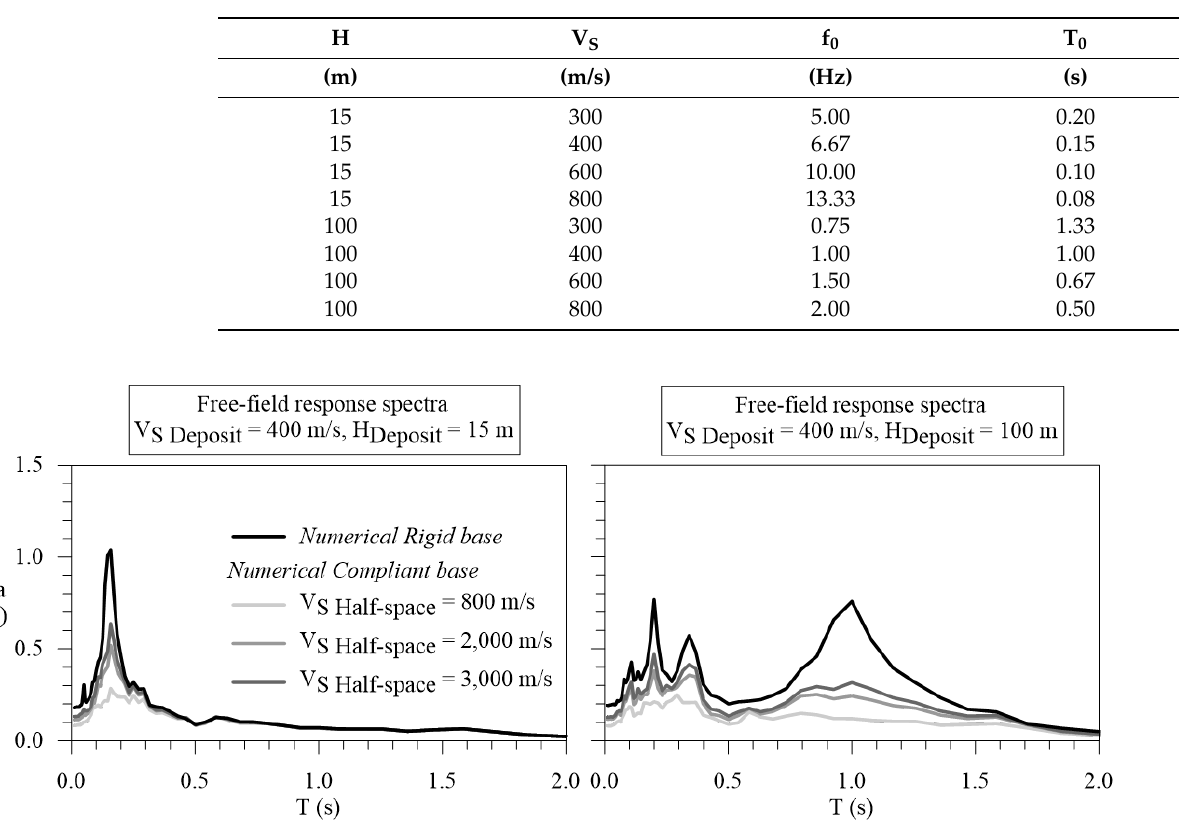
Figure 3. Response spectra in pseudo-acceleration obtained by means of rigid and elastic base conditions, with reference to linear visco-elastic materials and cover deposit thickness H equal to 15 m ( left side ) and 100 m ( right side ).